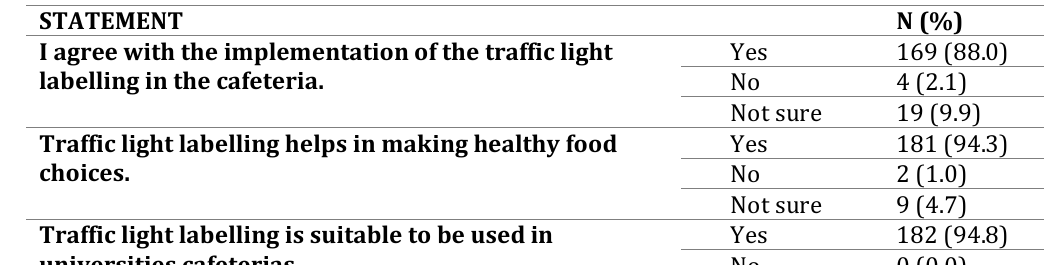
Table 5: Respondents’ perception towards implementation of TLL